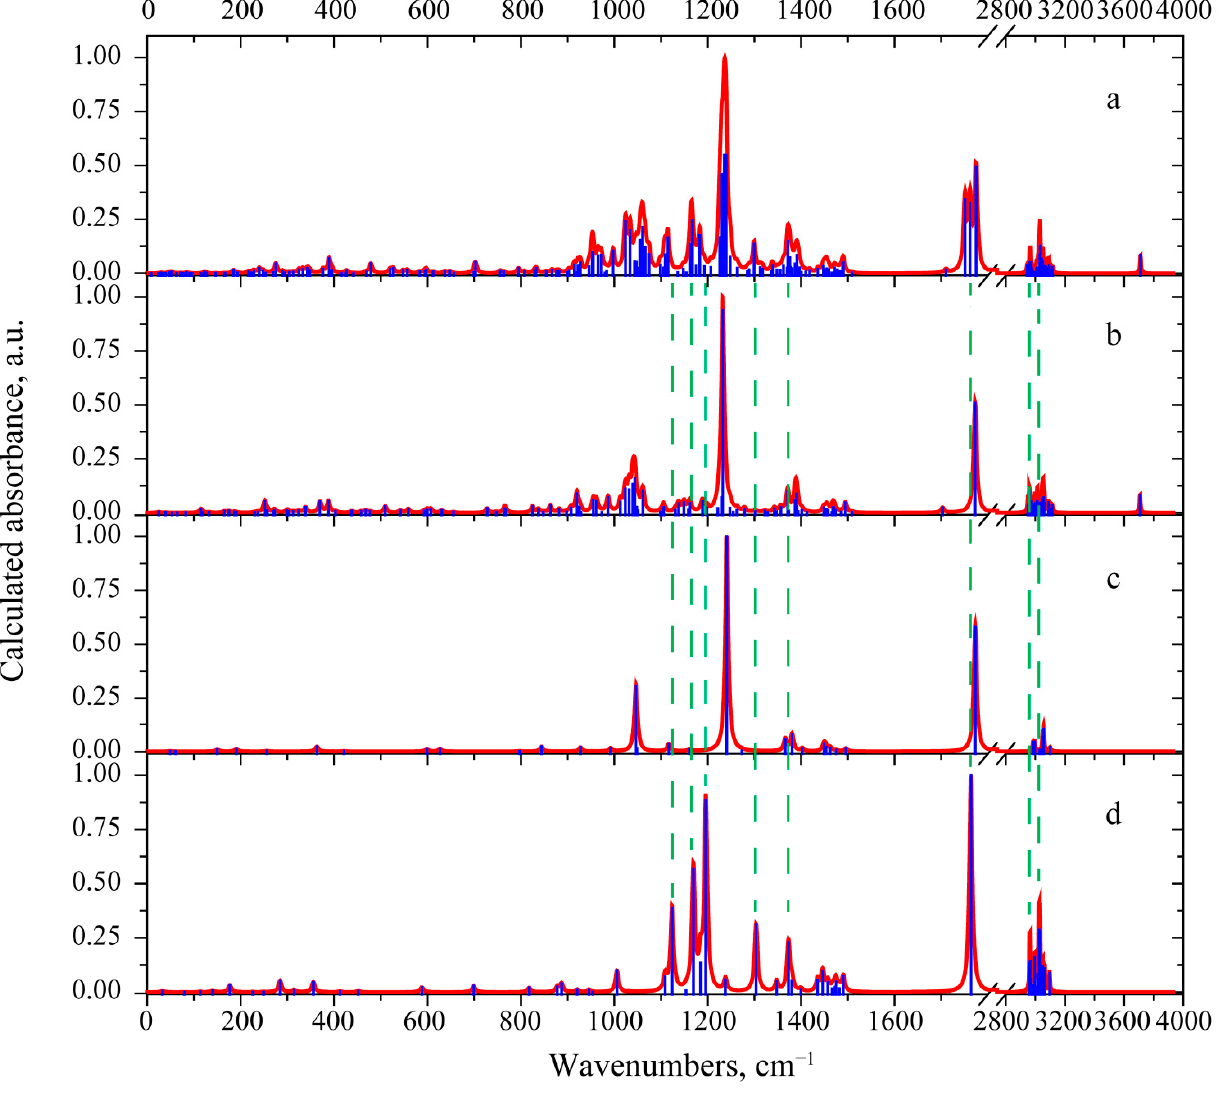
Figure 6. Calculated absorbance spectra for T-2 toxin ( a ), 3-deacetylcalonectrin ( b ), ethyl acetate ( c ) and methyl 3-methylbutanoate group ( d ). and methyl 3-methylbutanoate group ( d